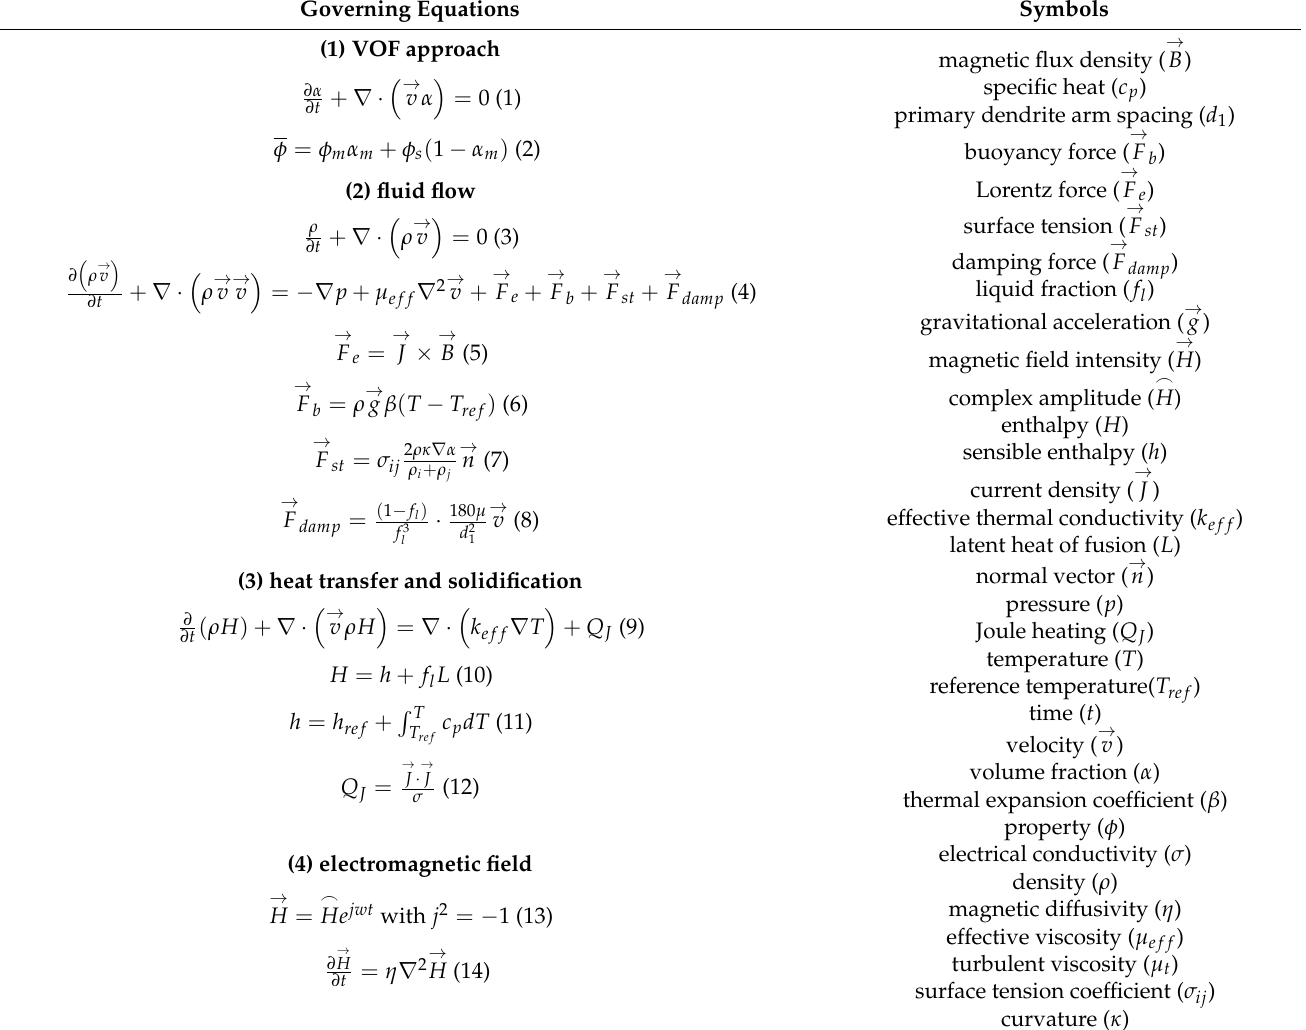
Table 1. Governing equations in this model